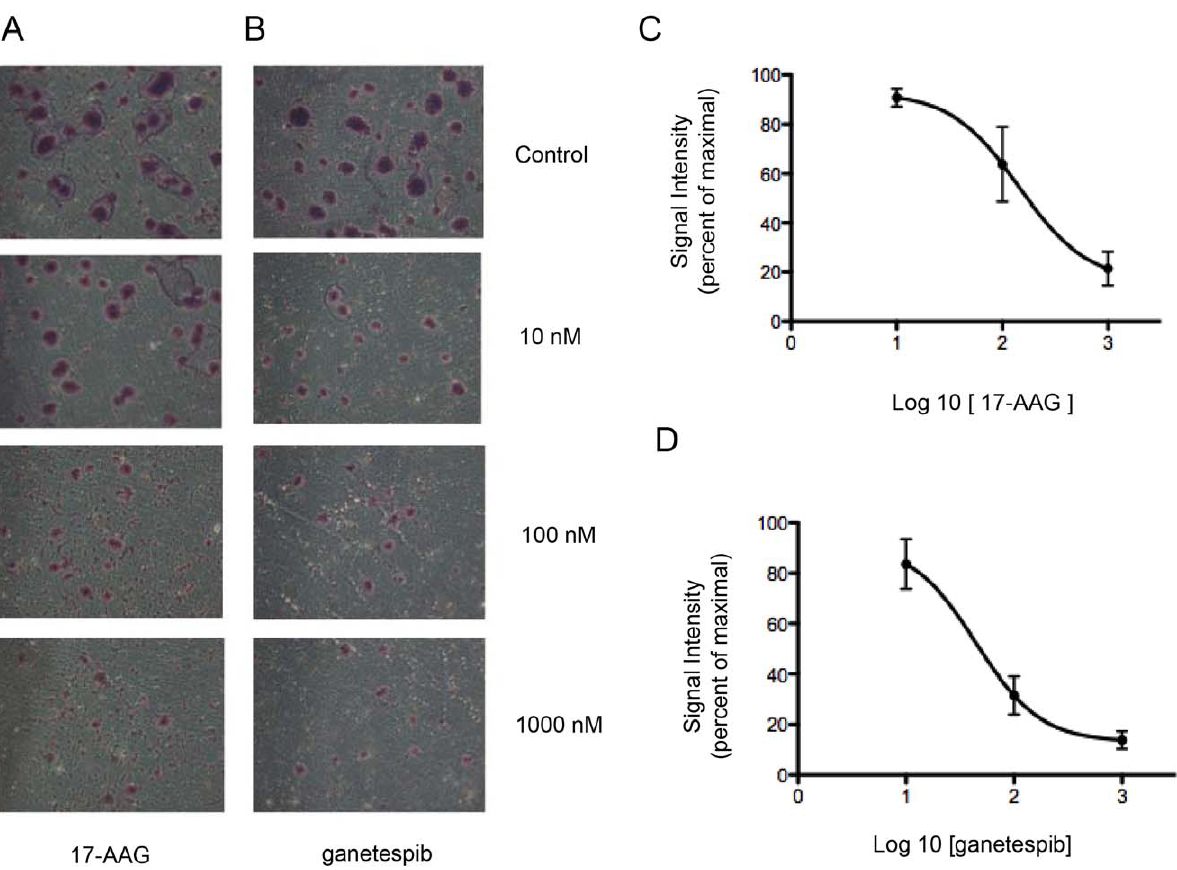
Figure 2. Incubation with 17-AAG or ganetespib inhibits cellular migration in pheochromocytoma MTT cells. Inhibition of migration by 17-AAG-treated (A) or ganetespib -treated (B) MTT cells in a Transwell assay in the presence of serum. Mean number of migrated cells per microscopic field (at 10 6 magnification) was determined from triplicate wells and is represented in this graph: 17-AAG (C) and ganetespib (D); error bars represent the standard deviation of triplicate determinations.